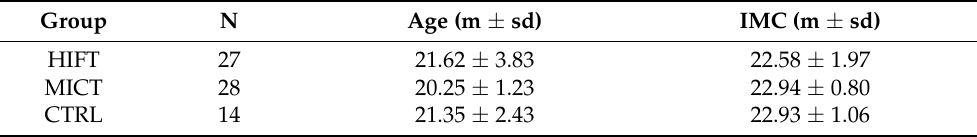
Table 1. Descriptives of age and IMC by group.